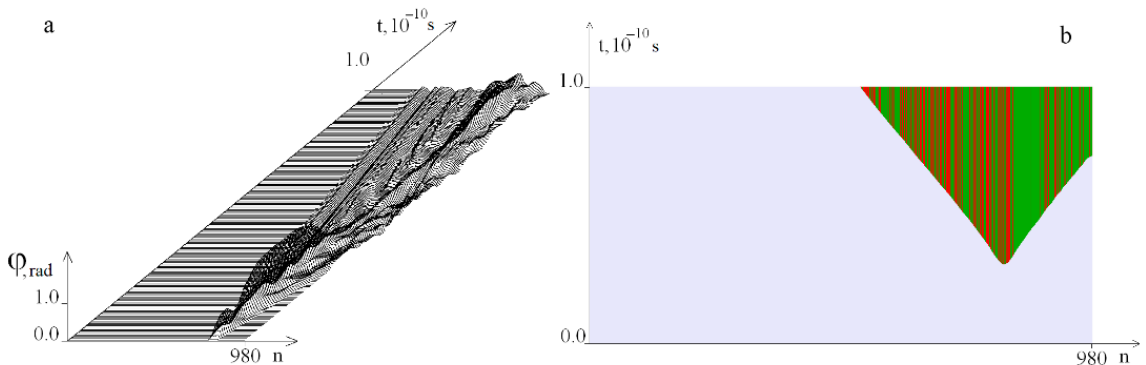
Figure 15. Influence of localized torque on a segment [781, 830]. a — Graph of the angular deviations of the first strand of the DNA molecule on the time interval [0, T 0 ] at M 0 = 21.12. b — OS regions at M 0 = 21.121, green color indicates OS in A – T pairs, red, in G – C pairs.